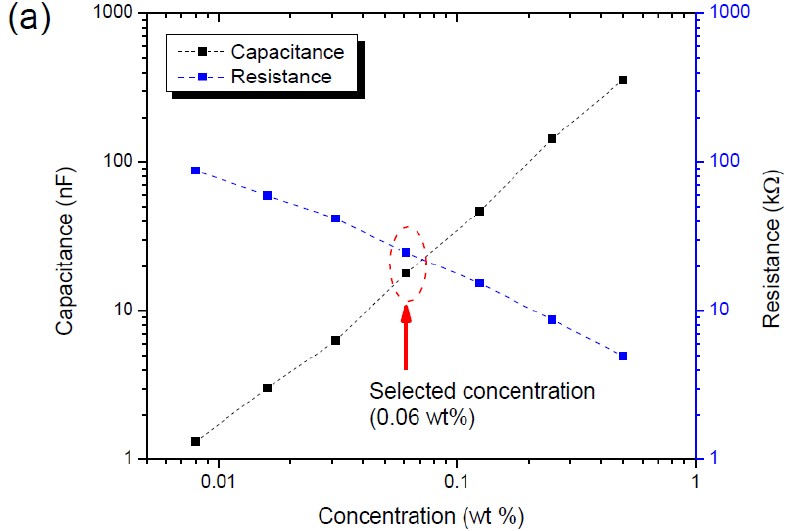
Figure 3. ( a ) Capacitance and resistance vs. concentrations, and ( b ) Standard deviation of both capacitance and resistance vs.